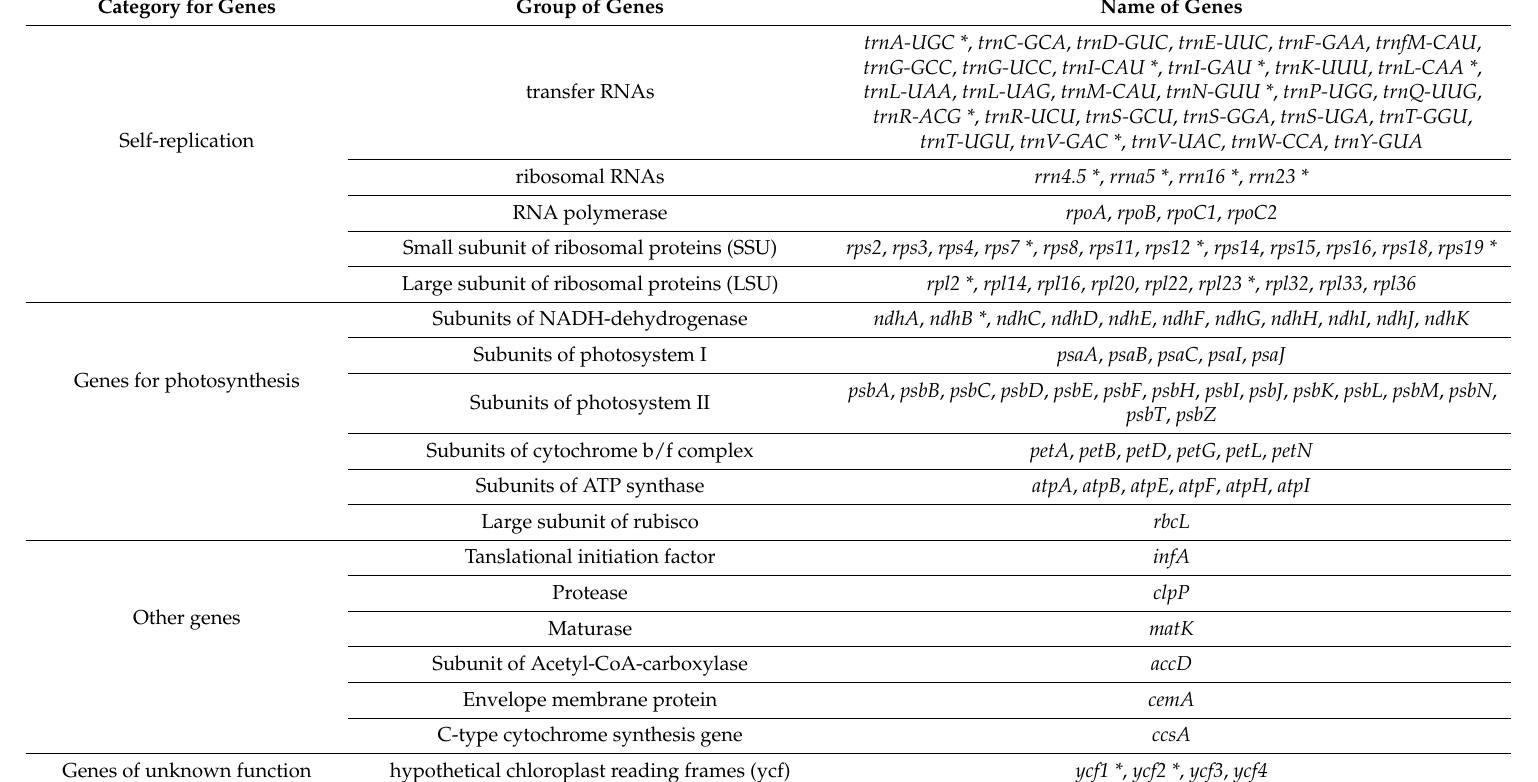
Table 3. List of genes encoded in two Urophysa species and S.